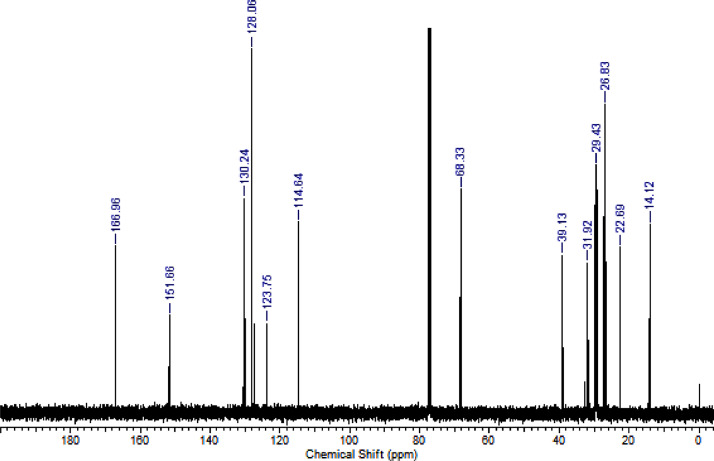
13C NMR (CDCl3, 100 MHz) spectrum of compound 8c.